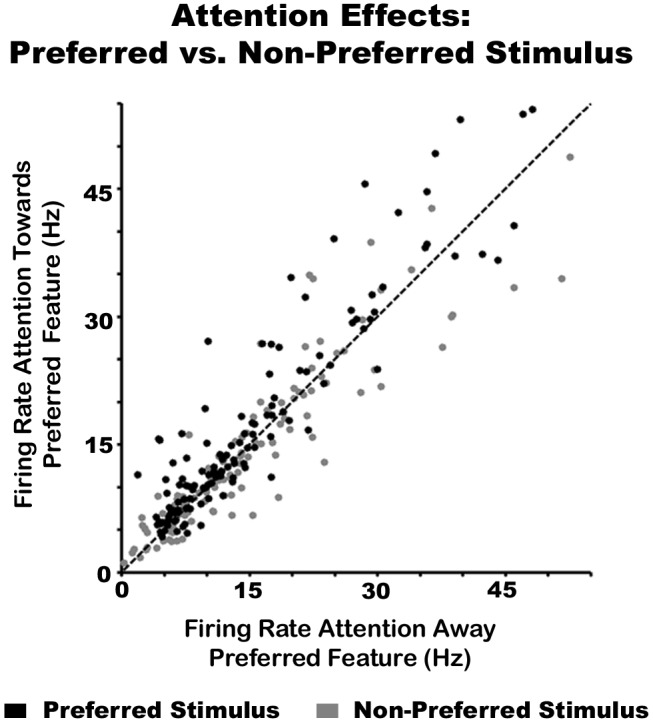
Attention effects are greater on the preferred stimulus value.The black and gray dots represent the FR of a neuron to its preferred and non-preferred stimulus value, respectively. The x-axis shows the response when attention was deployed away from the preferred feature modality, while the y-axis represents the response when attention was biased towards the preferred feature modality of the neuron. The dotted line is the identity. The underlying data used to make this figure can be found in Data S1.